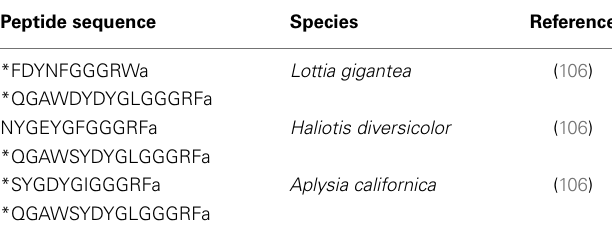
Table 6 | CCK/SK-like peptides .